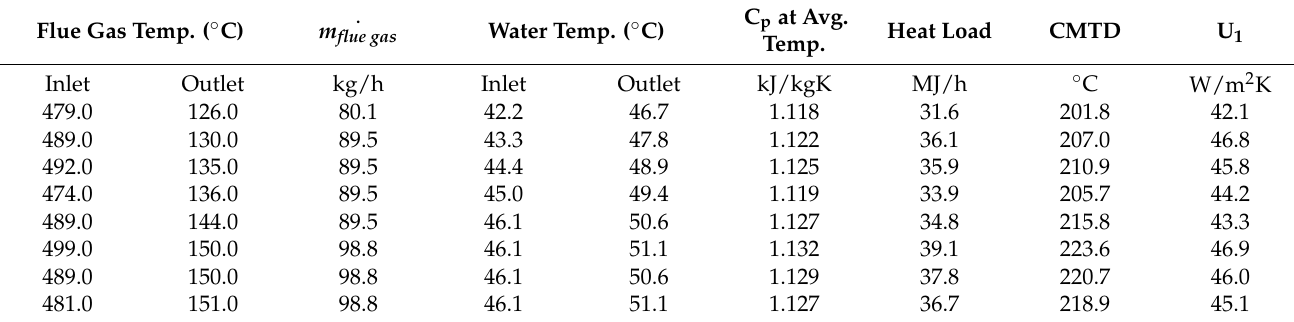
Table 2. Estimation of overall heat transfer coefficients (U 1 ) using the first